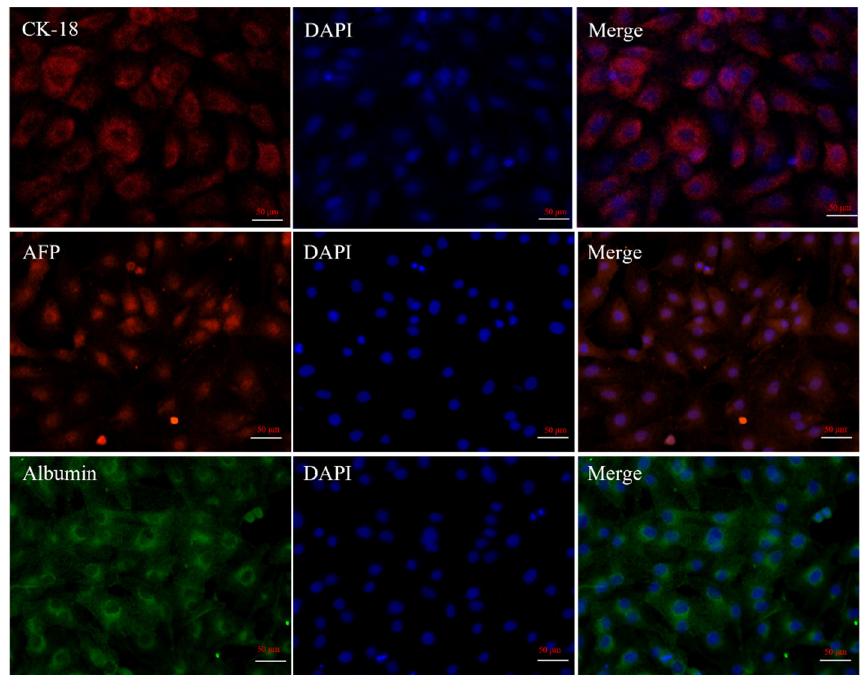
Figure 4. Characterization of primary sheep hepatocytes. Immunofluorescence analysis of isolated liver cells using antibodies corresponding to hepatocyte-specific marker cytokeratin 18, AFP, and albumin. Note: CK-18 and AFP are indicated with red fluorescence, albumin is green fluorescence, and DAPI is blue.